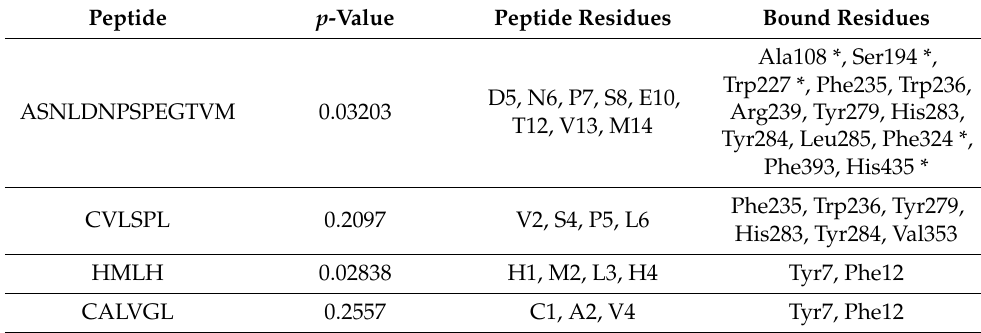
Table 2. Cont. Peptide p -Value Peptide Residues Bound